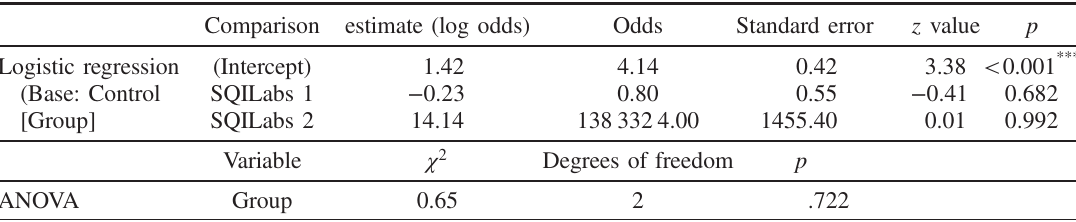
TABLE VI. Logistic regression and ANOVA table for whether students made changes to their Snell ’ s law measurements, examining only students with initially inaccurate measurements and those that did not make